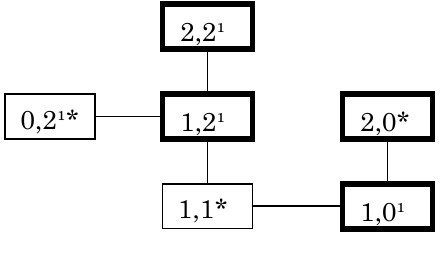
Fig. 5. Evaluation of attribute {d} based on reduct